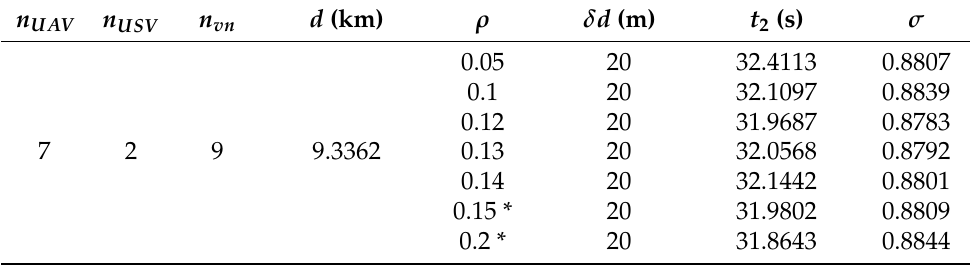
Table 15. Algorithm results: execution time (after time execution improvement) and performance indicator σ ( nt = 3, LB = 115 dB, d = 9.3362